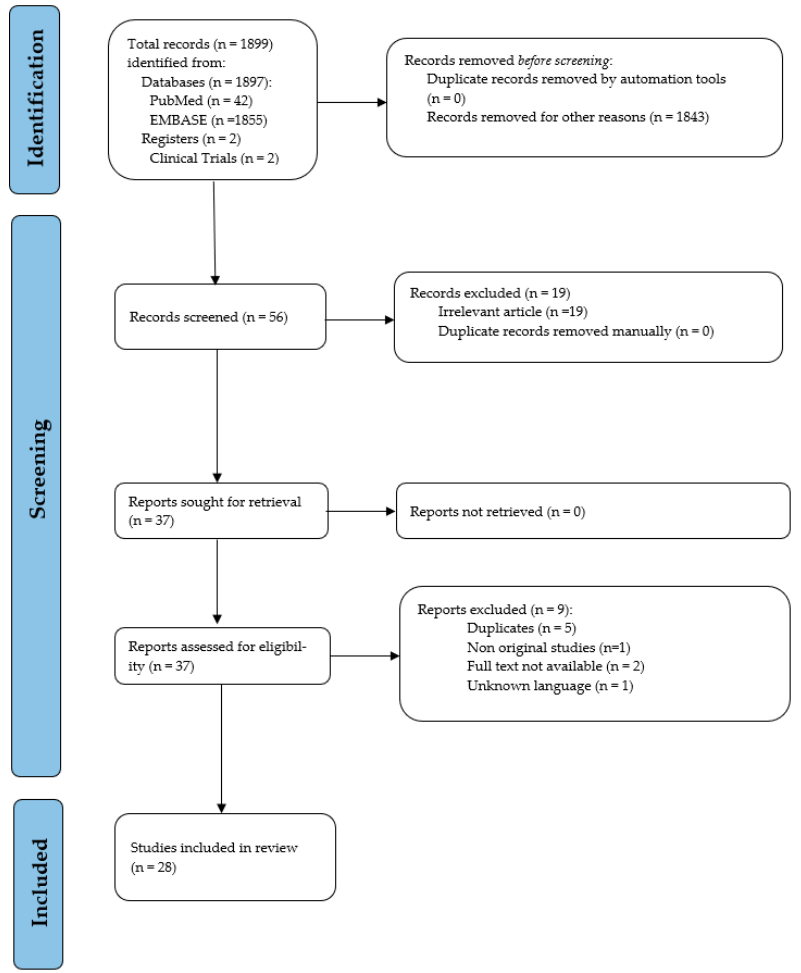
Figure 1. PRISMA flow diagram of study selection.